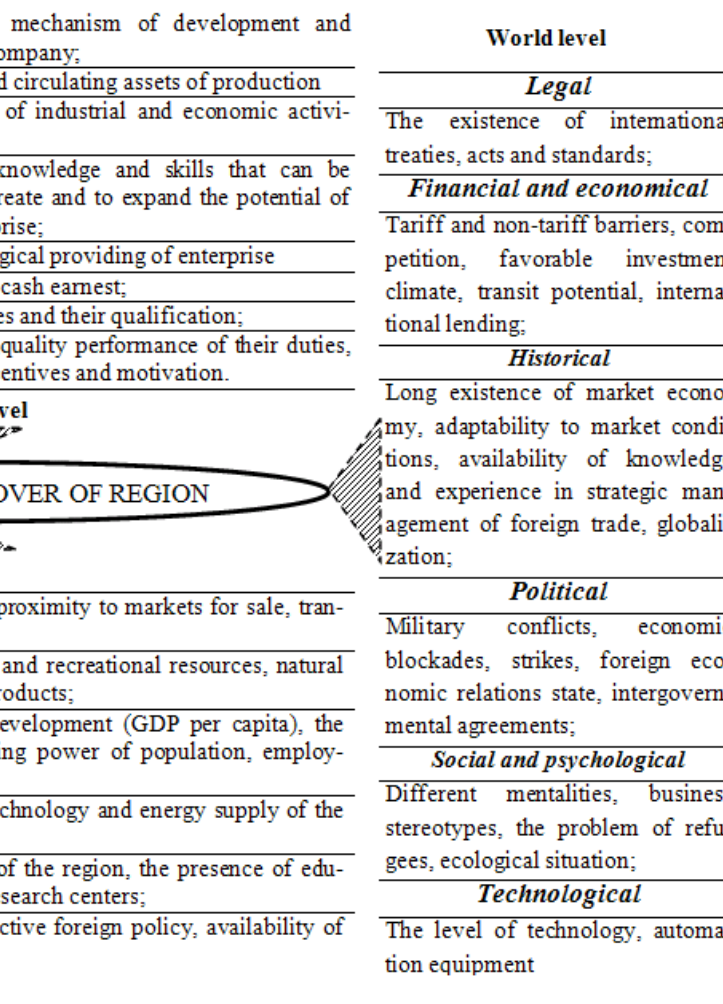
Fig. 3. Factors of influence on international trade in terms of